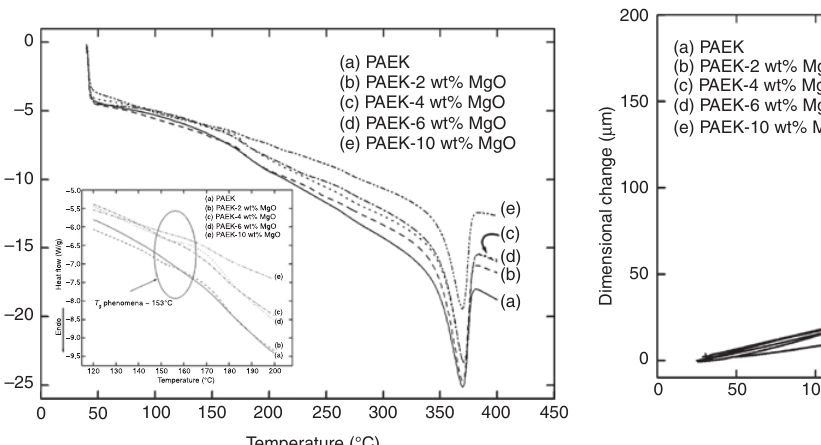
Figure 9: TMA plots using (A) penetration probe and (B) expansion probe for PAEK-MgO